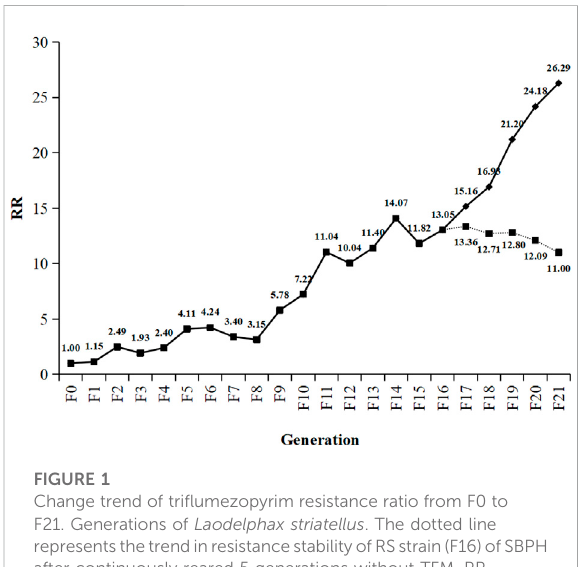
FIGURE 1 Change trend of tri fl umezopyrim resistance ratio from F0 to F21. Generations of Laodelphax striatellus . The dotted line representsthetrendinresistancestabilityofRSstrain(F16)ofSBPH